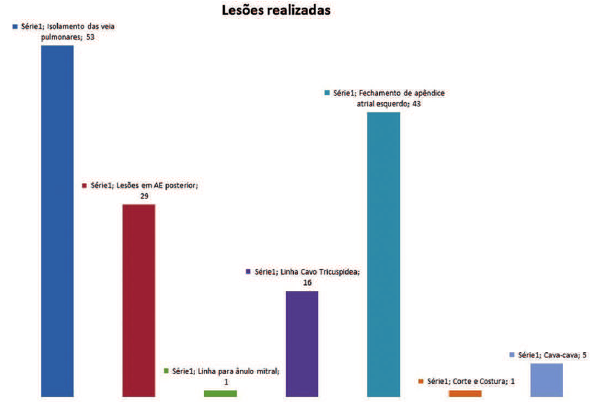
Fig. 1 - Tipos de cirurgia realizados. TVM = troca de valva mitral; TVA = troca de valva aórtica, PT = plastia tricúspide